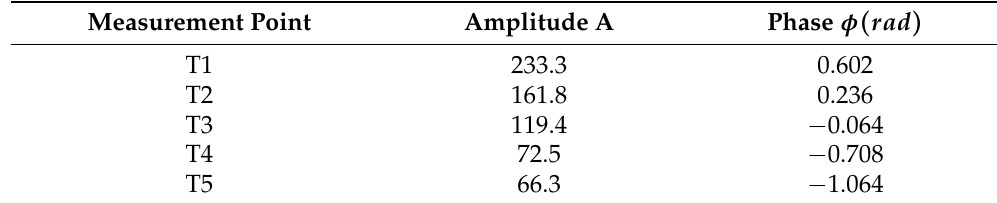
Table 4. Amplitude and phase for the component within a period of 24 h for January 2020 at measurement points.